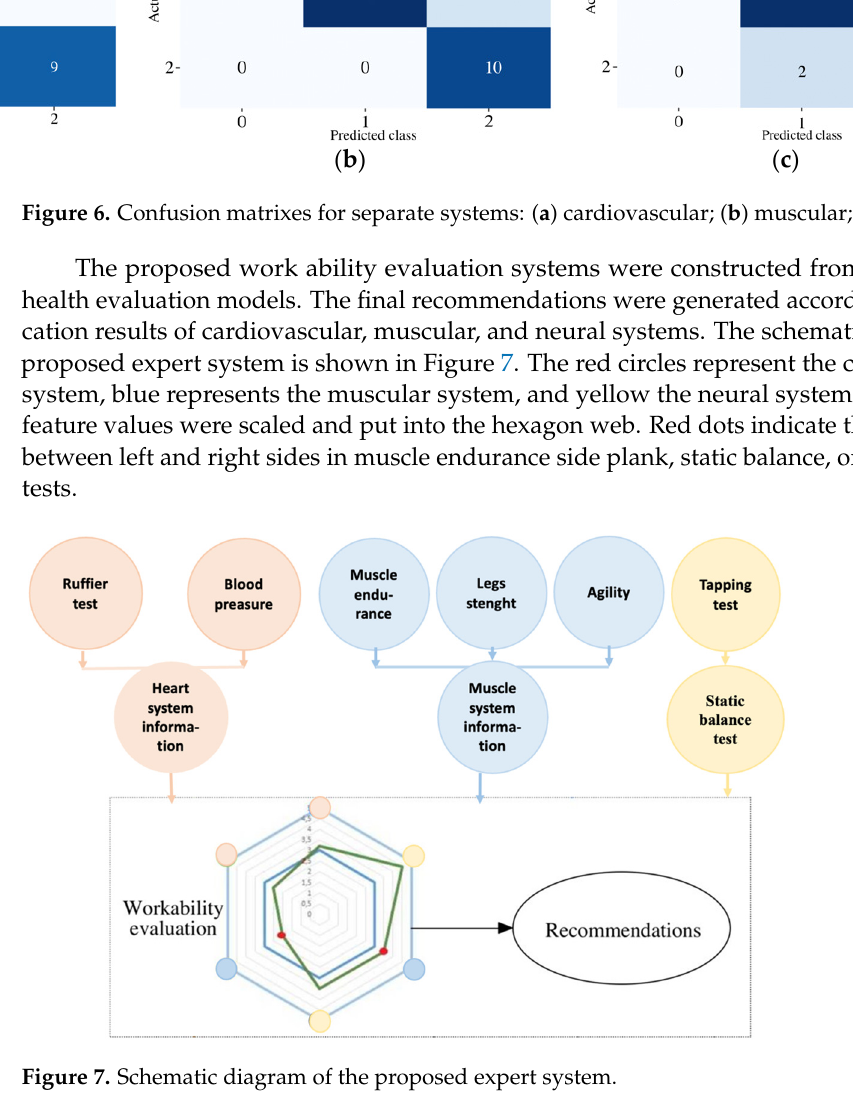
Figure 7. Schematic diagram of the proposed expert system.